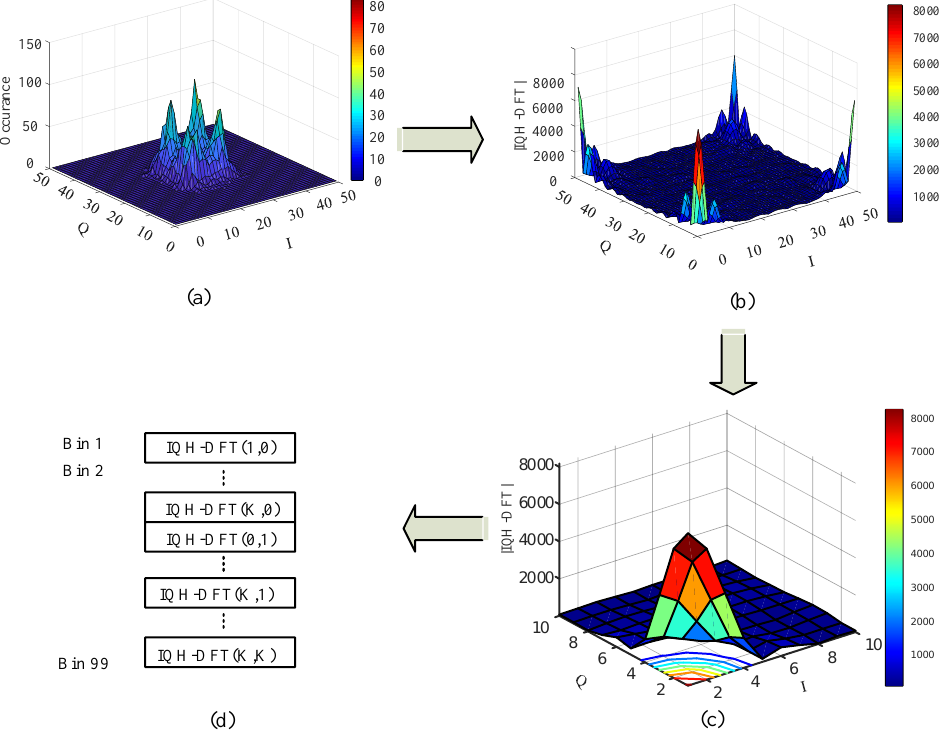
Figure 5. The concept of generating the 1D features vector, V-DFT, from the IQH of the QPSK signal. ( a ) IQH features, ( b ) IQH-DFT features, ( c ) Truncated IQH-DFT, ( d ) V-DFT